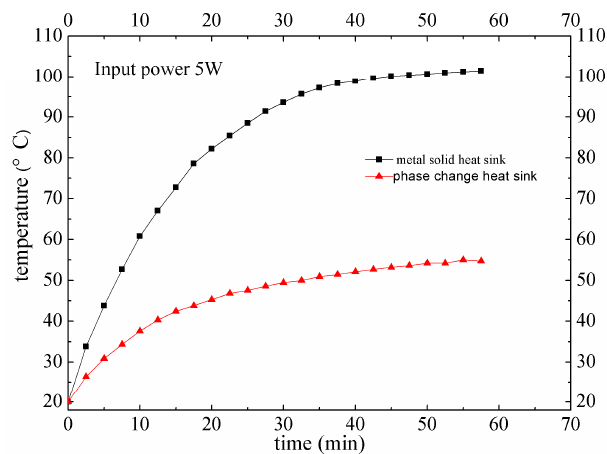
Figure 16. Heat transfer performance of phase change heat sink vs. metal solid heat sink.